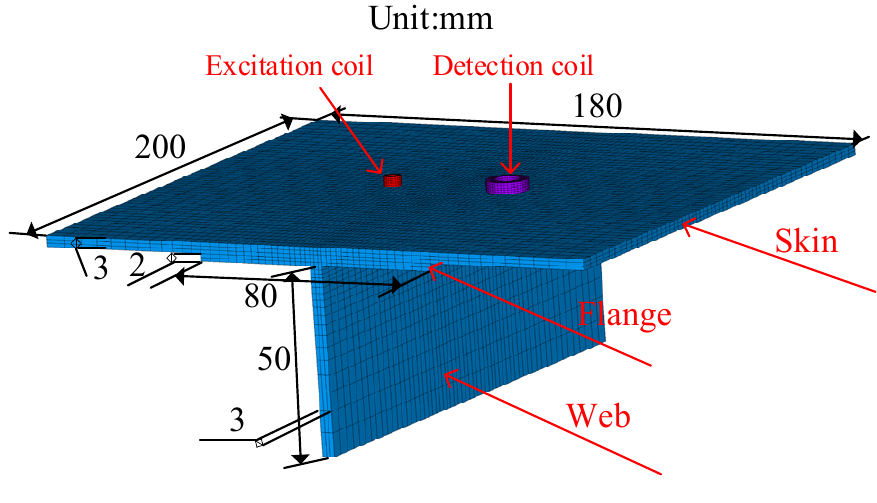
Figure 5. Aircraft long truss size